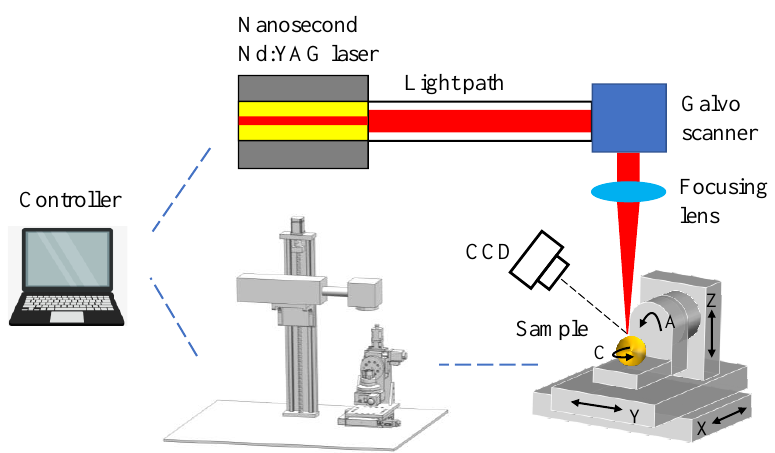
Figure 1. Schematic illustration of the MALM configuration.